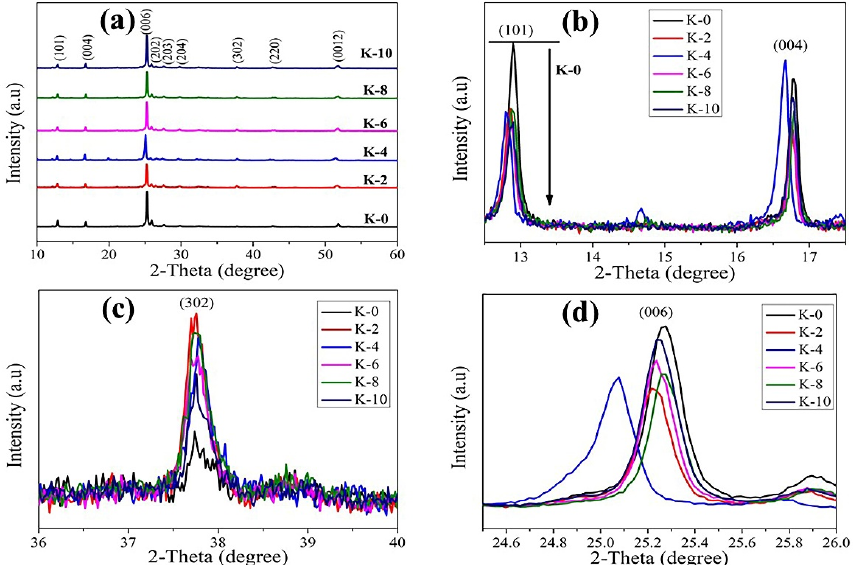
Figure 3. ( a ) XRD patterns of Cs ₃ Bi ₂ I ₉ and Cs ₃ Bi ₂ I ₉ perovskite devices with different concentrations of KI, ( b ) magnified view of XRD patterns of prepared perovskite devices (K = 0–10 vol%) show a decrease in BiI ₃ peak intensity around 2 θ = 12.7°, ( c ) magnified view of XRD patterns at 37.758° (302), and (d) variation in (006) peak around 2 θ = 25.259° with KI incorporation. Figure 3 displays the XRD patterns obtained when studying the Cs ₃ Bi ₂ I ₉ PSCs sam- ples with different concentrations of KI incorporated into the absorber films, and shows the effect of KI on the perovskite film-phase crystallization. For the PSC film without KI (K-0), the diffraction peaks observed at 2 θ = 12.838 (101) and 25.208 (006) indicate the presence of excess unreacted BiI ₃ [38]. The addition of KI systematically decreases the in- tensity of BiI ₃ peaks, as can be observed in Figure 3a,b, which is in agreement with potas- sium passivation [39]. Intense peaks at 2 θ = 12.838°, 16.713°, 25.208°, 25.802°, 27.506°, 29.96°, and 51.751° correspond to the (101), (004), (006), (202), (203), (204), and (0012) planes of the Cs ₃ Bi ₂ I ₉ lattice and are characteristic of this perovskite phase. The XRD patterns exhibited sharp diffraction peaks, indicating that the ternary Cs ₃ Bi ₂ I ₉ perovskite structures generated were highly crystalline. The XRD data acquired were a good match with the historic JCPDS card number 23-0847 [40]. Despite the poor resolution, peaks that match these planes can be seen in the experimental data. The size of the nanocrystals may be to blame for the prominent peaks, but the many little peaks within ranges of 2 θ observed in the reference pattern were also possible causes. It has been previously stated that broad signals obtained in nanocrystal production can be at- tributable to tiny particle sizes. Because of this, we know that the Pb-free perovskite struc- tures were formed successfully. As seen in Figure 3c, peak shift is typically more noticeable at greater angles. The 37.758° hkl (302) peak was carefully scanned to observe the extremely few changes in peak positions. The (302) peak of the K-0 sample shifts towards a lower angle, and this demon- strates that iodine occupies an interstitial location and causes a lower angle shift. The K-2 sample displays a more pronounced shift and has the maximum intensity compared to the other samples, indicating that the as-prepared perovskite film’s crystalline structure is significantly larger. It suggests that too much iodine causes halide exchange even when potassium is present. This explains why the K-2 sample exhibits greater lattice (hexagonal) expansion than the samples K-4, K-6, K-8, and K-10, which contain extra iodine. In